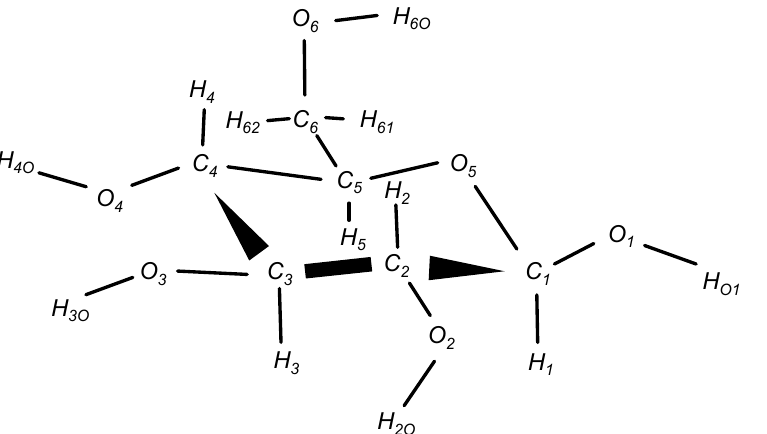
Figure 1. Molecular structure of β -glucose. The atomic labels are the same as those for the GLYCAM06 force field [22], and correspond to the atomic labels in the